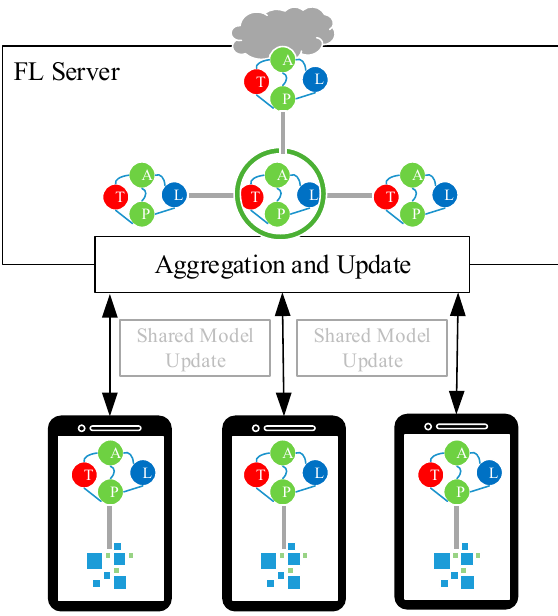
Figure 1. Framework of the FL-AHNEAP method.